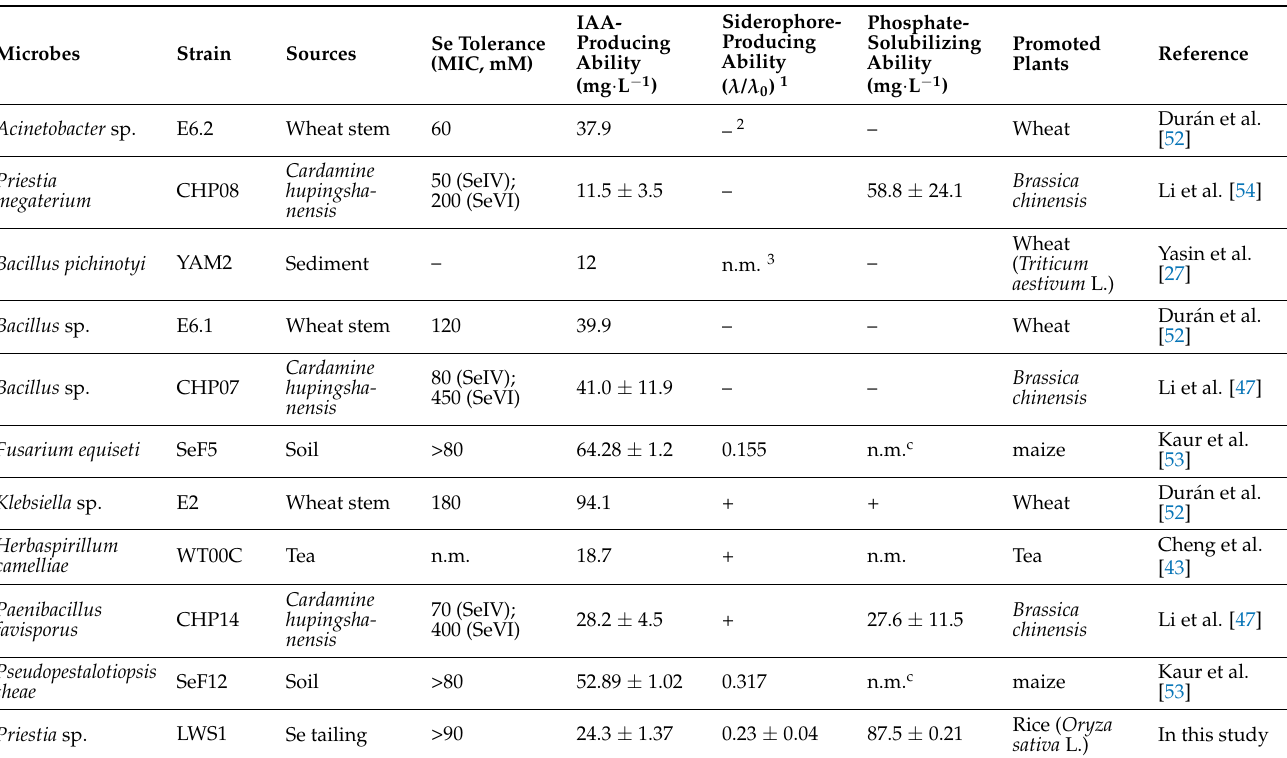
Table 1. Se-tolerance ability and PGP characteristics of the representative microbes reported previ-